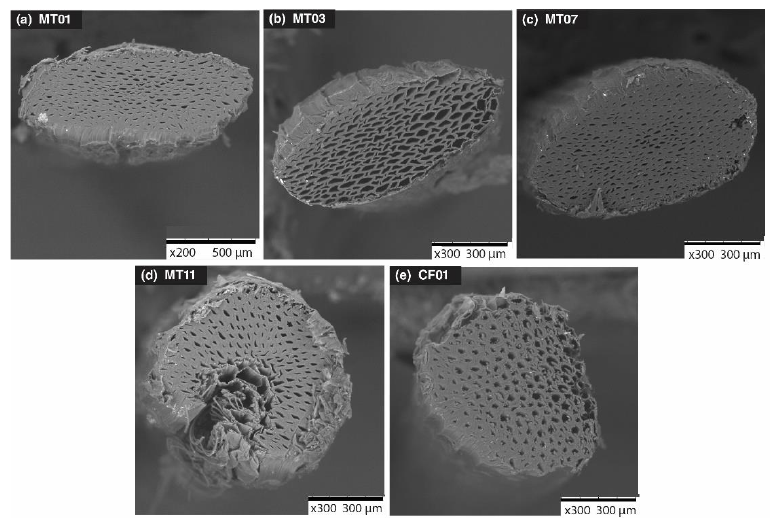
Figure 1. Electron microscopic cross-section view of the fibers of five genotypes of M. textilis .